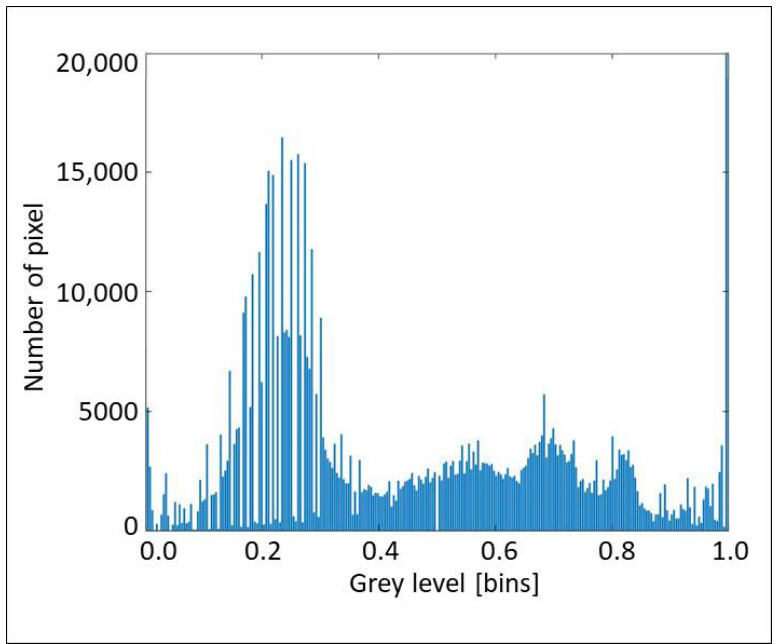
Figure 19. Histogram of grey scale vs. number of pixels for section B2 concerning layers and